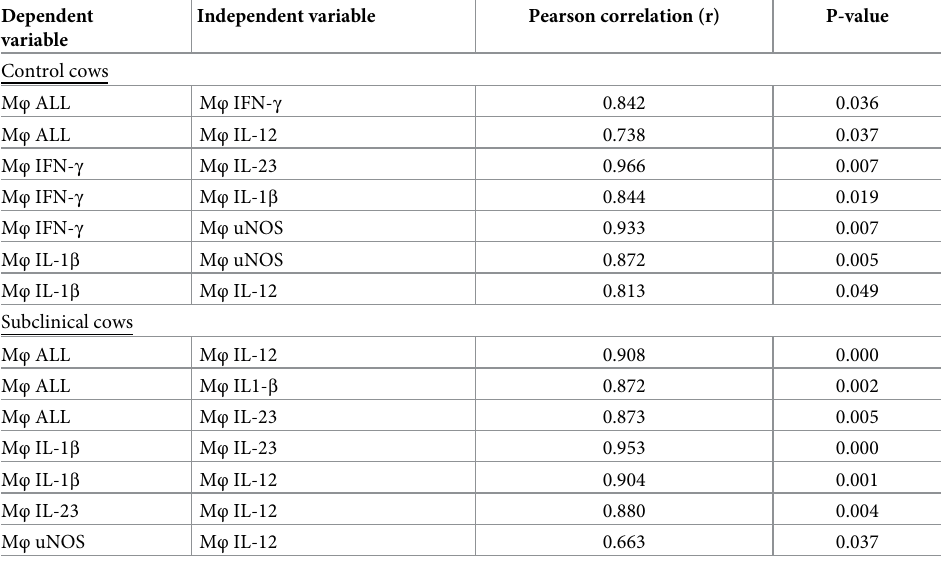
Table 3. Pairwise Pearson correlations between cytokines colocalized within host defense macrophages.